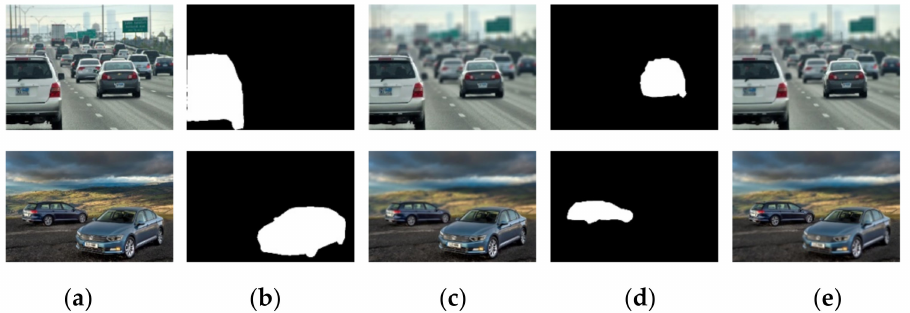
Figure 9. Bokeh images of different focal planes. ( a ) All-in-focus image; ( b ) focal planes 1; ( c ) bokeh image; ( d ) focal planes 2; ( e ) bokeh